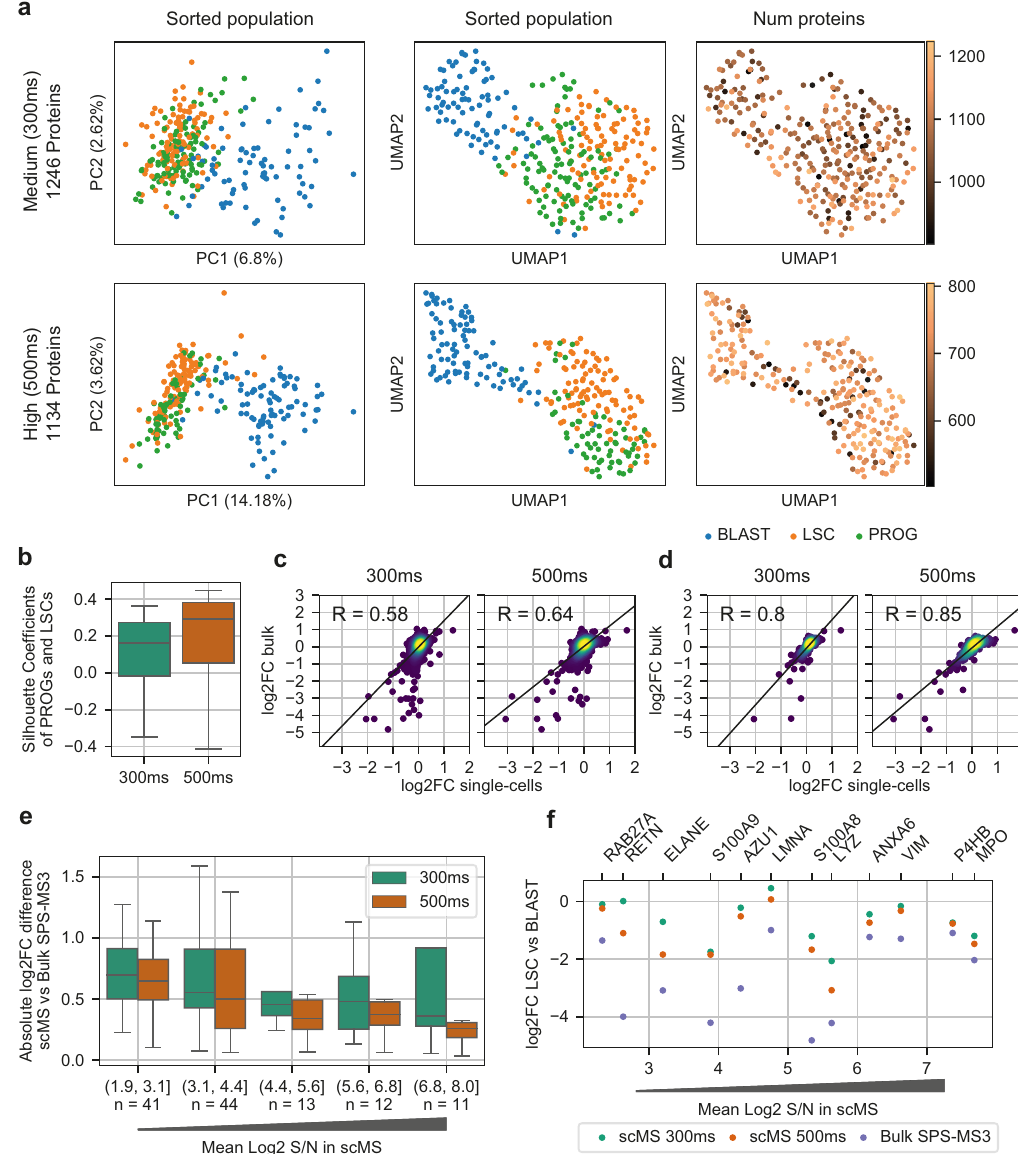
Fig. 3 Detection of cellular heterogeneity with the ‘ medium ’ and ‘ high ’ method. a Comparison of the PCA and UMAP embeddings resulting from the imputed protein matrix. Number of proteins refers to the non-imputed proteins measured per cell. ‘ Medium ’ = 302 cells, ‘ high ’ = 255 cells. BLAST = blasts, LSC = leukemia stem cells, PROG = progenitors. b Separation of populations measured by the silhouette coef fi cients of progenitors and LSCs calculated in UMAP space for 300 ms ( n = 219) and 500 ms ( n = 166). Boxplot shows median, 0.25 and 0.75 quantile, and whiskers extend to points within 1.5 interquartile range of lower and upper quartile. c Pearson correlation of the protein fold changes (log2FC) between blasts and LSCs measured in the scMS work fl ow and MS3 bulk-sorted data. Non-imputed values were used and only proteins with ≥ 3 values in blasts and LSCs respectively were considered. Number of proteins in 300 ms and 500 ms is n = 1725 and n = 1342, respectively. d Same analysis as in panel c, but with the top 400 high-coverage proteins selected for each dataset. e Absolute log2FC difference of proteins of LSC vs. blast between scMS and MS3 bulk-sorted data across intensity bins. Only proteins that were signi fi cantly changed between LSC and blast in the MS3 bulk-sorted data were selected for comparison (FDR < 0.05, absolute log2FC > 0.5). Proteins were binned across their mean log2 signal-to-noise (S/N) in the 300 ms and 500 ms dataset. n = number of proteins with absolute fold change difference plotted. Boxplot shows median, 0.25 and 0.75 quantile, and whiskers extend to points within 1.5 interquartile range of lower and upper quartile. Outliers not shown. f log2FC of selected proteins in 300 ms, 500 ms, and MS3 bulk-sorted data. Proteins were binned into 12 bins across their mean log2 S/N in the 300 ms and 500 ms dataset. From each bin the protein with the highest absolute fold-change between LSC and blast in the MS3 bulk-sorted data was selected for comparison with scMS ratios. Source data are provided as a Source Data fi